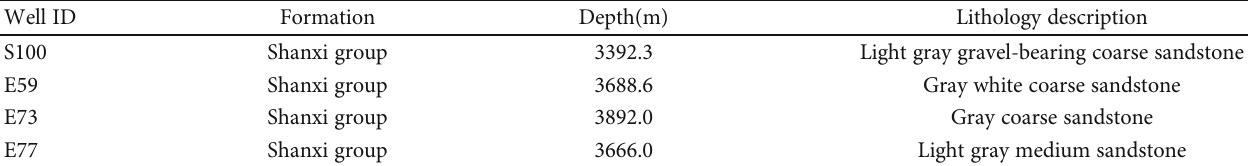
Table 1: Sampling formation of Upper Paleozoic clastic zircon in the northwestern Ordos